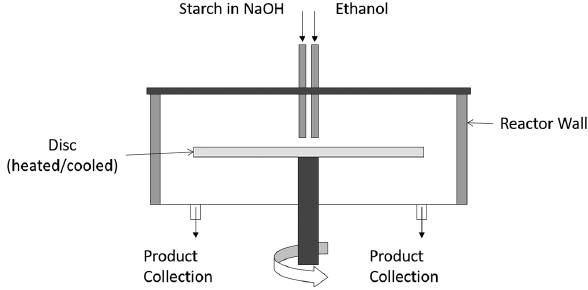
Figure 1: Schematic of